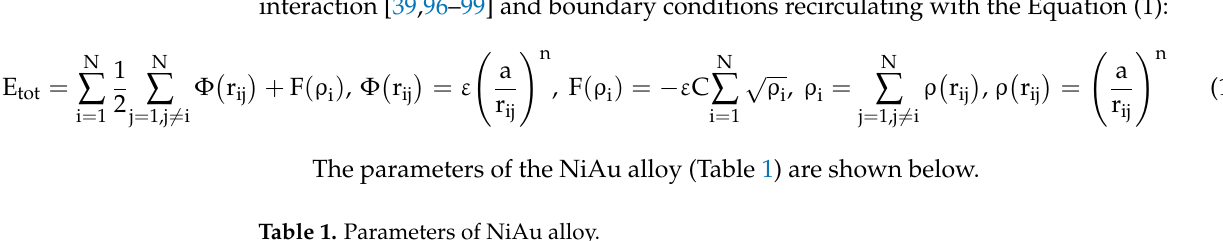
Table 1. Parameters of NiAu